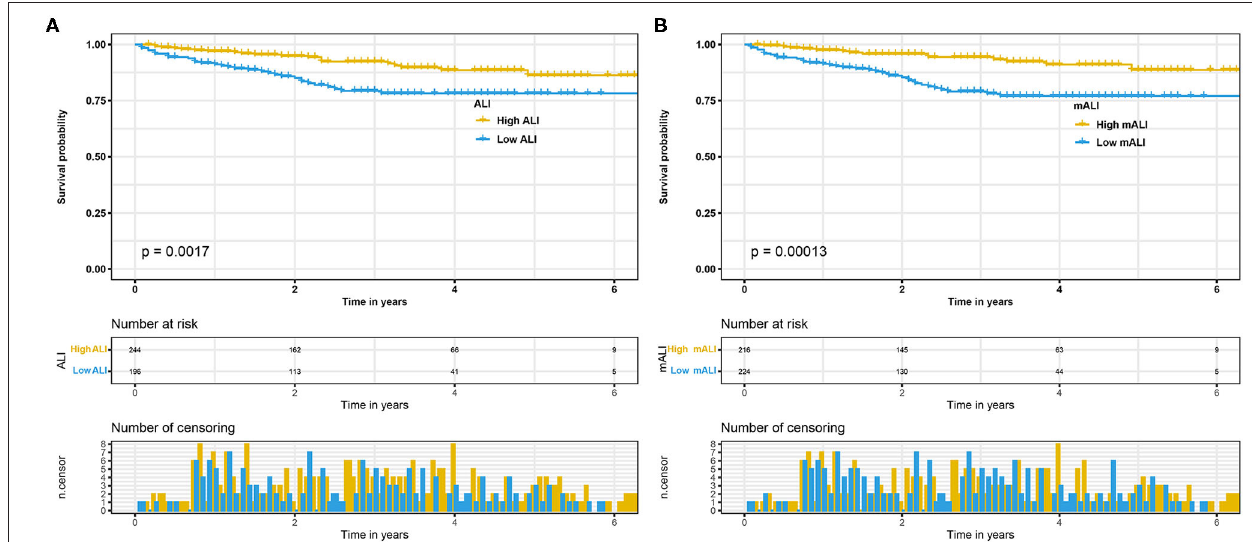
FIGURE 3 | Kaplan-Meier curves for OS stratified by ALI and mALI before PSM. (A) ALI OS; (B) mALI OS. OS, overall survival; ALI, advanced lung cancer inflammation index; mALI, modified advanced lung cancer inflammation index; PSM, propensity score matching.